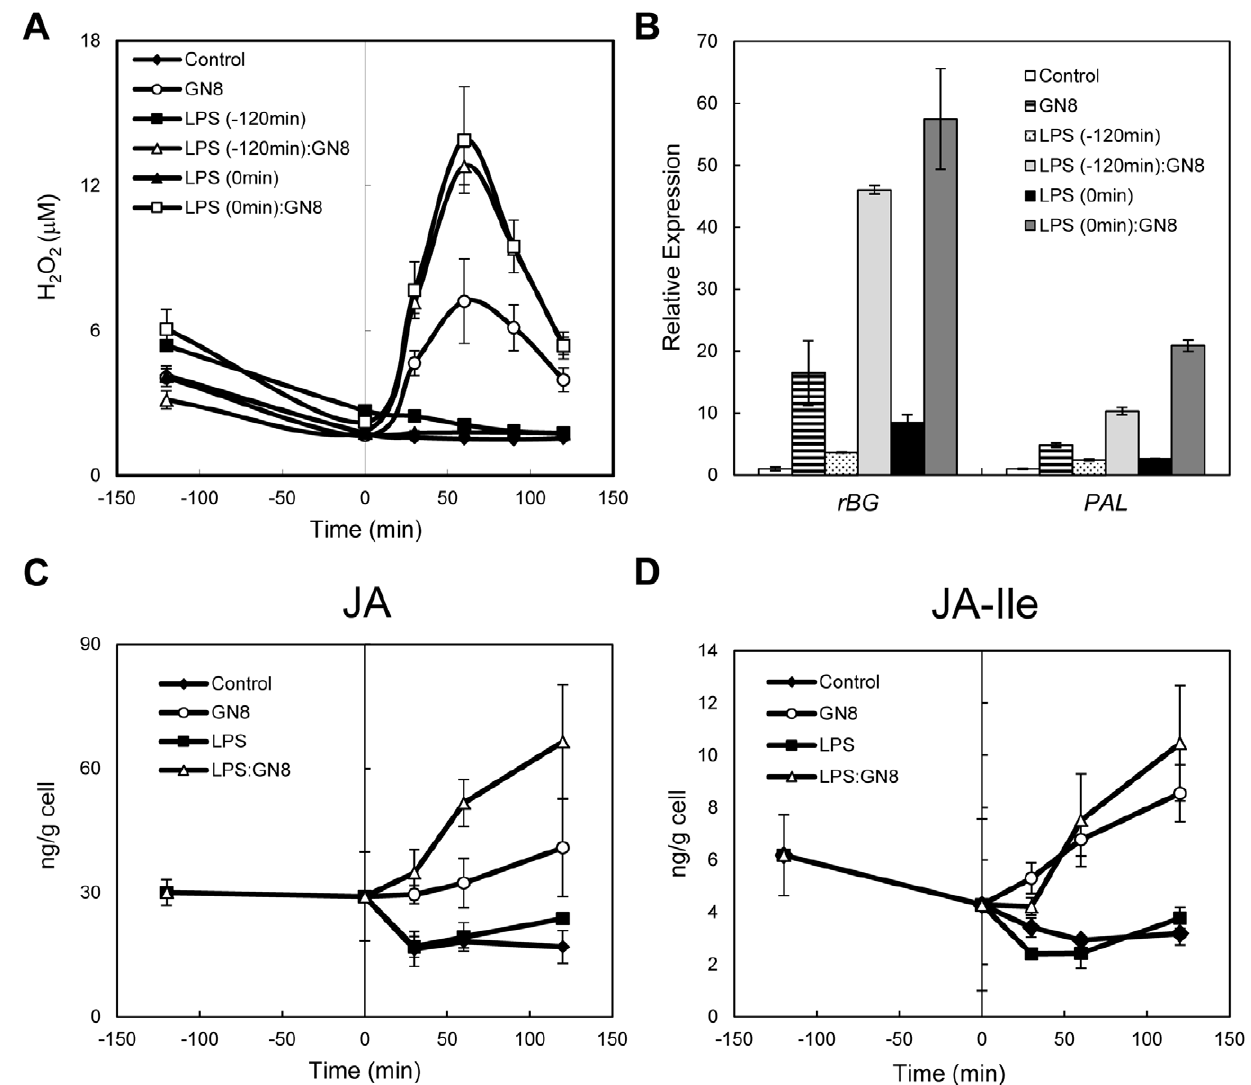
Figure 3. Comparison of ‘‘priming’’ and ‘‘synergy’’. (A, B) ROS generation and defense gene expression induced by simultaneous treatment with LPS and GN8, or LPS pretreatment (-120 min) and successive GN8 treatment (0 min). LPS concentration was 0.1 m g/ml and GN8 concentration was 0.08 ng/ml. (C, D) Changes in JA and JA-Ile concentration after simultaneous treatment with LPS (0.1 m g/ml) and GN8 (0.08 ng/ml). Synergistic effect was observed for the accumulation of JA but not for JA-Ile. Experimental conditions were the same to Fig.